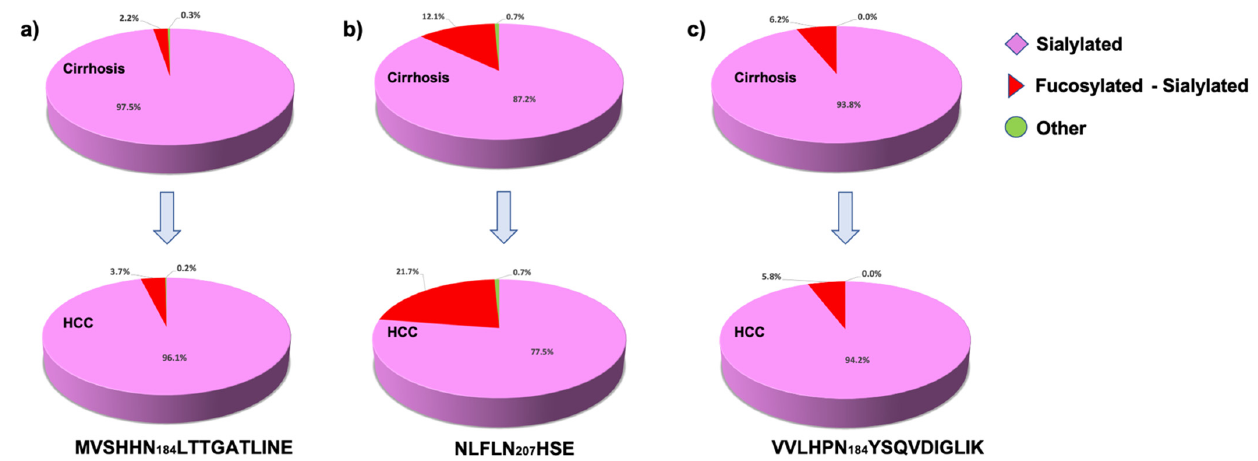
Figure 6. Glycome changes in abundance of serum haptoglobin associated with cirrhosis and HCC samples. Serum haptoglobin sites, as follows: ( a ) MVSHHN 184 LTTGATLINE; ( b ) NLFLN 207 HSE; and ( c ) VVLHPN 241 YSQVDIGLIK. The significant changes were observed on the glycosylation site NLFLN 207 HSE, where the sialylated glycans changed from 87.2% to 77.5% ( p- value 0.0001), and the fucosylated sialylated glycans changed from 12.1% to 21.7% ( p -value 0.0001).